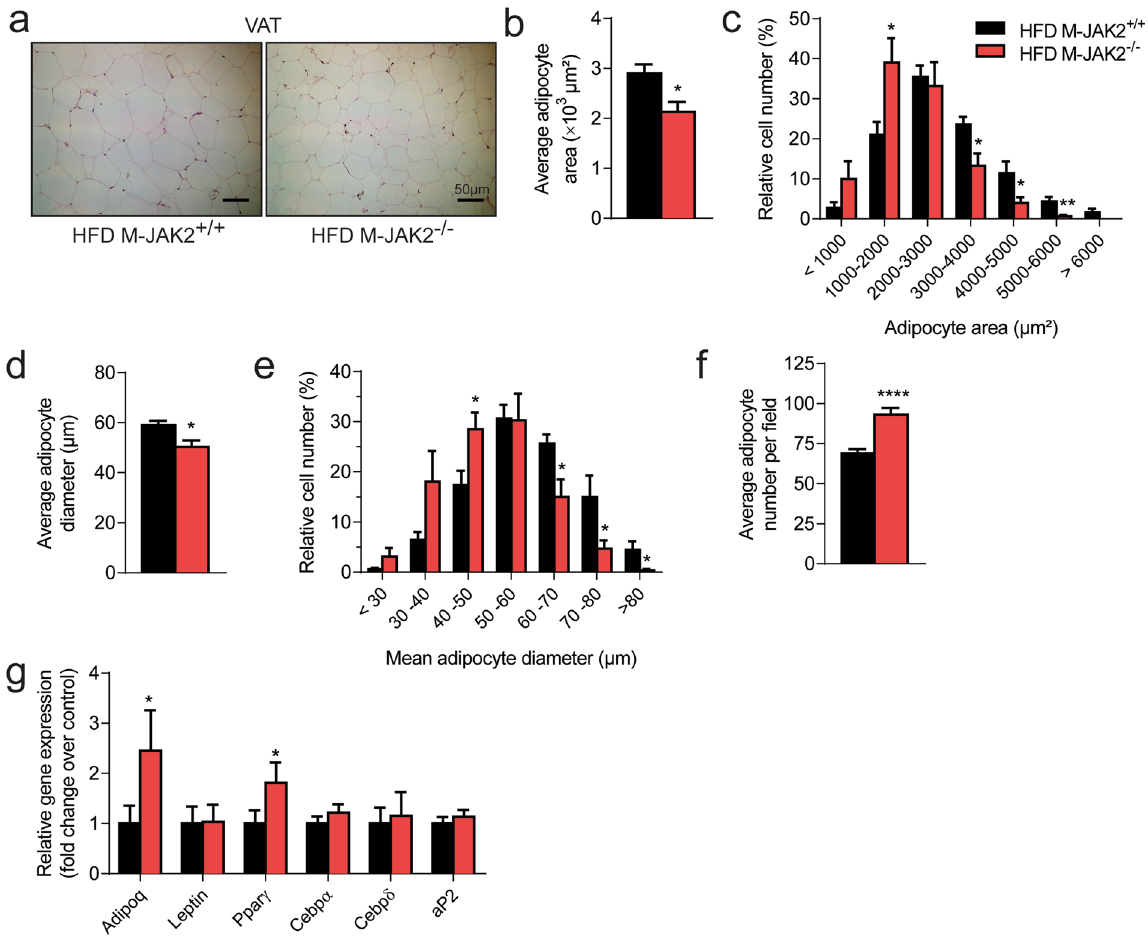
Figure 2. Decreased adipocyte hypertrophy in HFD-fed M-JAK2 − / − mice. ( a ) Representative micrographs of H&E stained VAT sections of HFD-fed M-JAK2 + / + and M-JAK2 − / − mice. Quantitative analysis of adipocytes in VAT sections from HFD fed M-JAK2 + / + and M-JAK2 − / − (n = 7–9): ( b ) average adipocyte area, ( c ) adipocyte area distribution, ( d ) average adipocyte diameter, ( e ) adipocyte diameter distribution, and ( f ) adipocyte number per field. ( g ) mRNA expression of genes involved in adipogenesis in VAT of HFD fed M-JAK2 + / + and M-JAK2 − / − mice (n = 8–10). All results are mean ± SEM; * p < 0.05, ** p < 0.01, **** p <